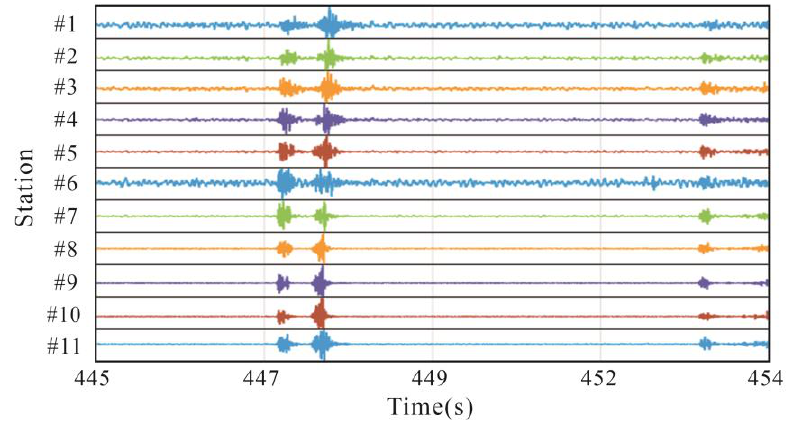
Figure 6. Waves of each seismometer in huddle test.